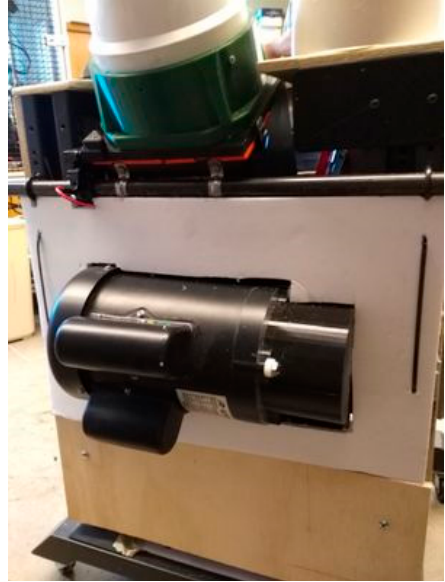
Figure 8. Granulator panel gaps filled with sound proofing material.